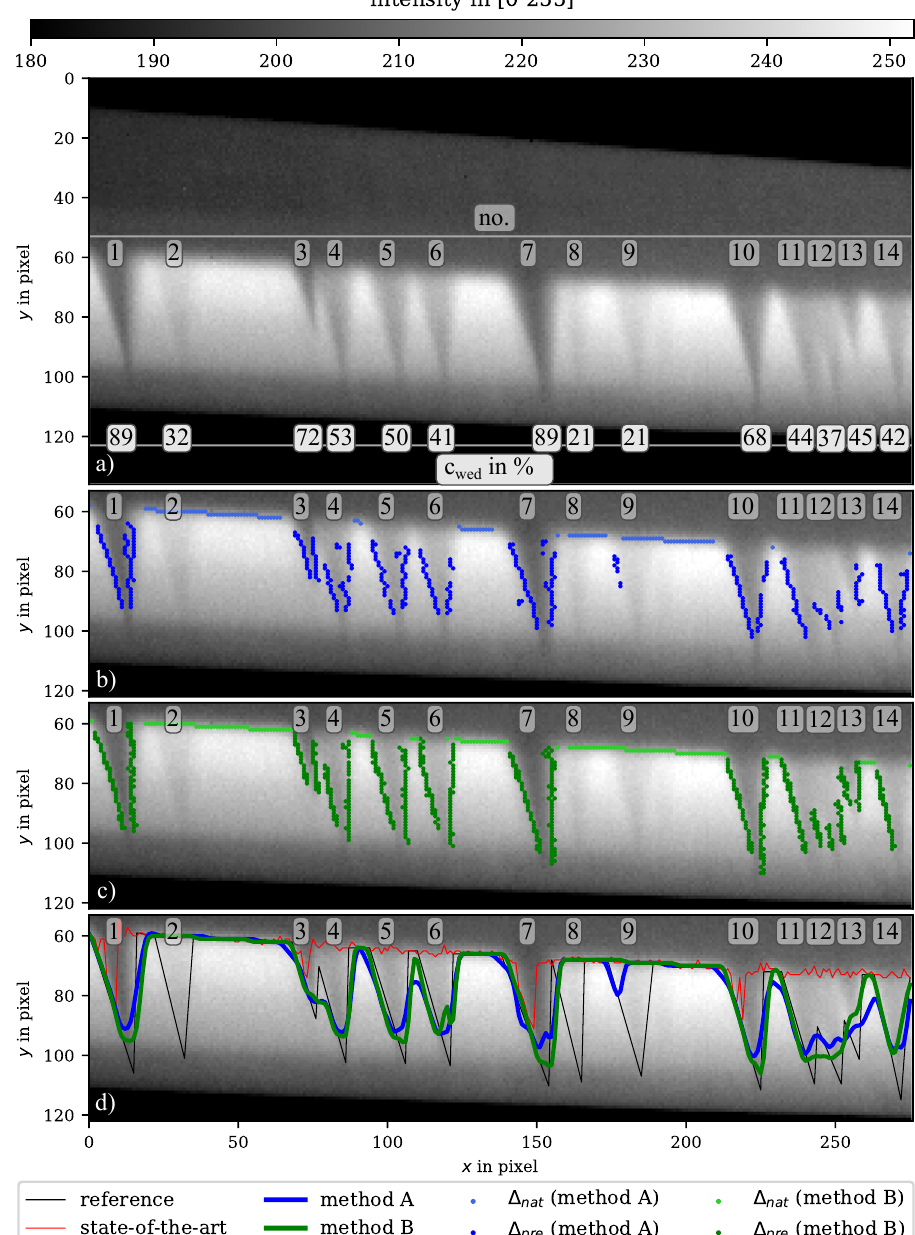
Figure 13. Measured thermographic image for flow visualization. ( a ) Complete image with marked laminar flow regime area with a numbering above and relative contrast c wed below for each turbulence wedges. ( b , c ) Located local temperature gradient maxima ∆ nat (brighter) and ∆ pre (darker) of both introduced gradient evaluation methods A and B in blue and green, respectively. ( d ) Final evaluated transition line of the state-of-the-art evaluation (red), the evaluation of methods A (blue) and method B (green), as well as the manually evaluated transition line (black) as